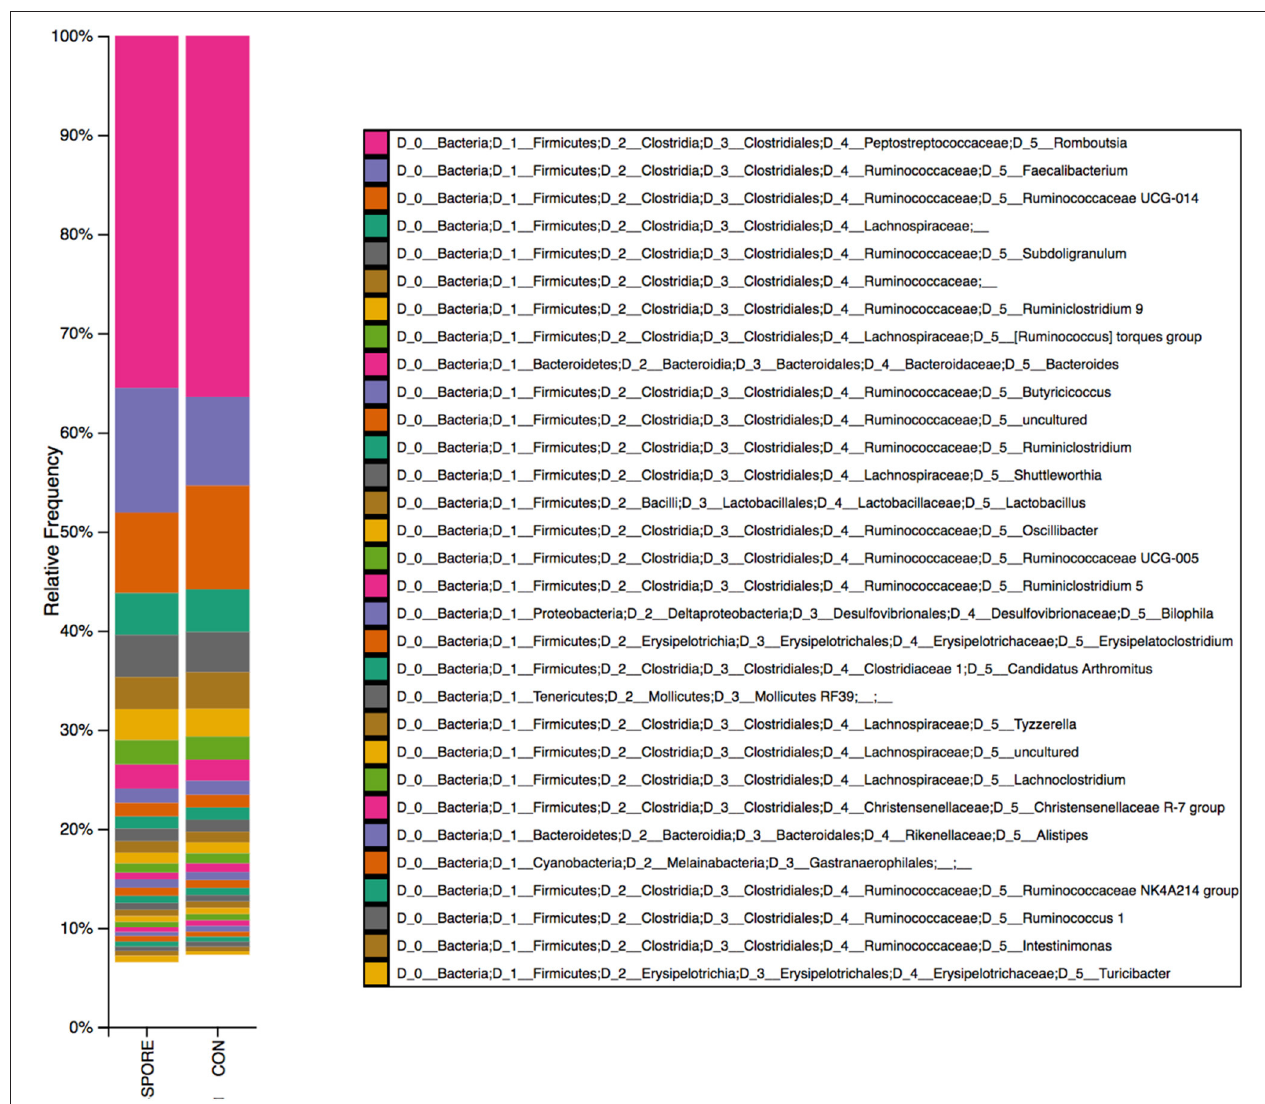
FIGURE 2 | 16S reads identified in SPORE and CON inocula. Bacterial taxa from spore-enriched (SPORE) and control (CON) inocula were identified via 16S rRNA gene sequencing and QIIME2 pipeline analysis.